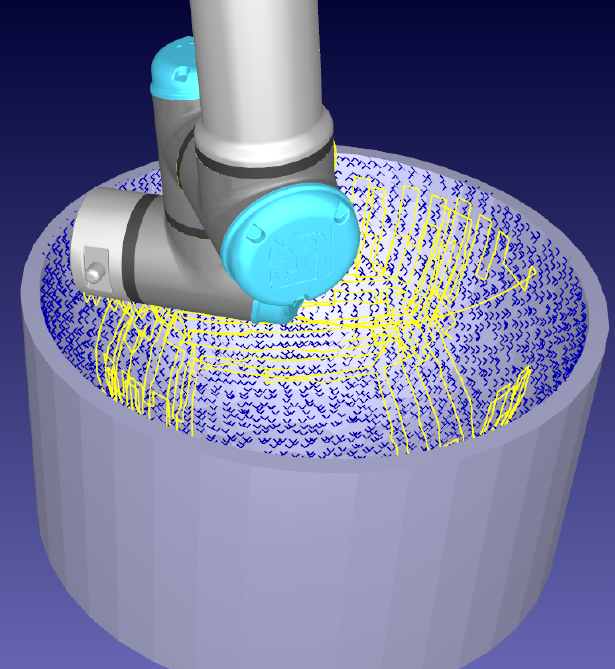
Figure 8. Sampling on a concave shape. The robotic path, that can form irregular patterns without a preferred direction, is shown in yellow. Discovered points on the bowl are shown as blue crosses.